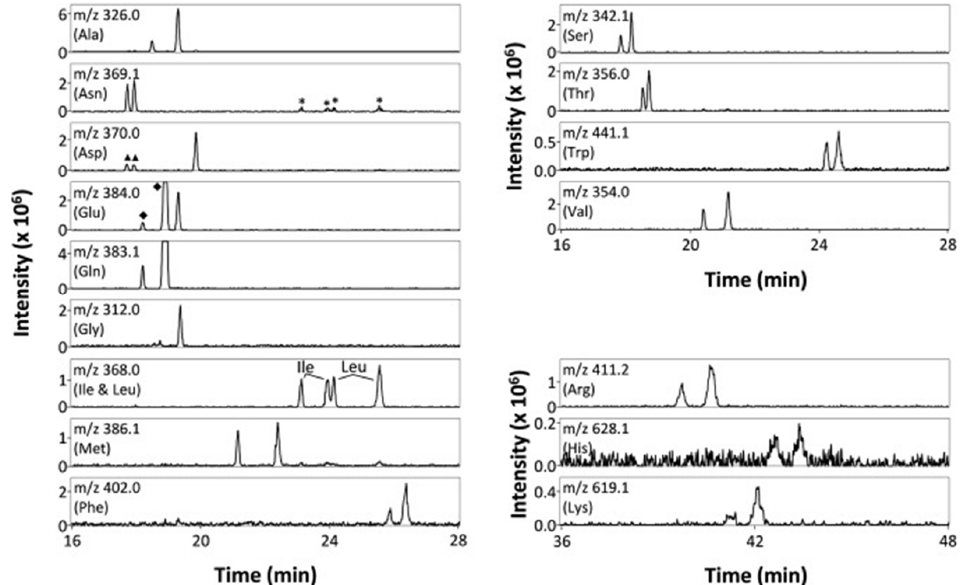
Figure 6. Extracted ion electropherograms obtained during chiral CE-MS of CSF spiked with DL-Ms. Conditions: BGE, 150 mM APFO (pH 9.5); spiked concentration per AA enantiomer, 3.2 µg mL-1 in CSF; sheath liquid, isopropanol-water-formic acid (90:10:0.1 v / v / v ); sheath liquid flow rate, 3 µL. Asterisks indicate signals of the mono isotope peaks of D - and L -isoleucine and o- and L-leucine. Triangles indicate the mono CB isotope peaks of D- and L- asparagine. Diamonds indicate mono CB isotope peaks of D- and L- glutamine. Both Figure and Figure caption is adapted from Prior et al. [58], with permission from